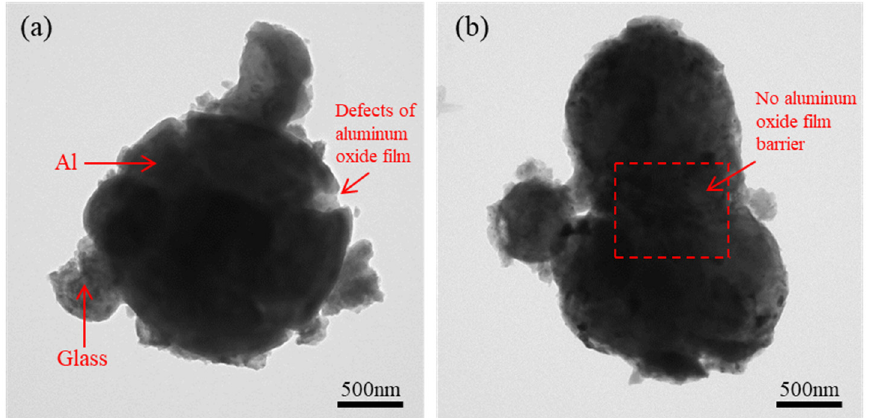
Figure 8. TEM images of the mixture of aluminum powder, glass powder and sodium carbonate after sintering at 620 °C. ( a ): TEM image of a single aluminum particle in the mixed powder; ( b ): TEM image of the connection between aluminum particles in the mixed powder.